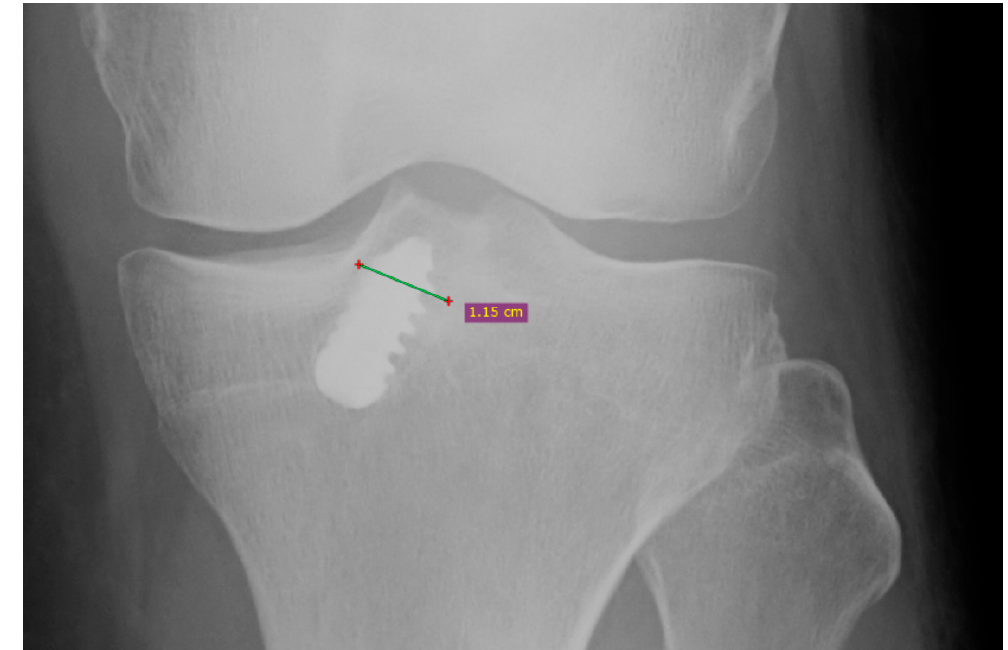
Figure 4. Assessment of tibial tunnel widening on an AP radiograph 18 months postoperatively. Radiograph of the left knee performed in the anteroposterior projection with straight knee. The tibial tunnel width was measured manually. A line was drawn at the widest point of the tunnel, perpendicular to its long axis.